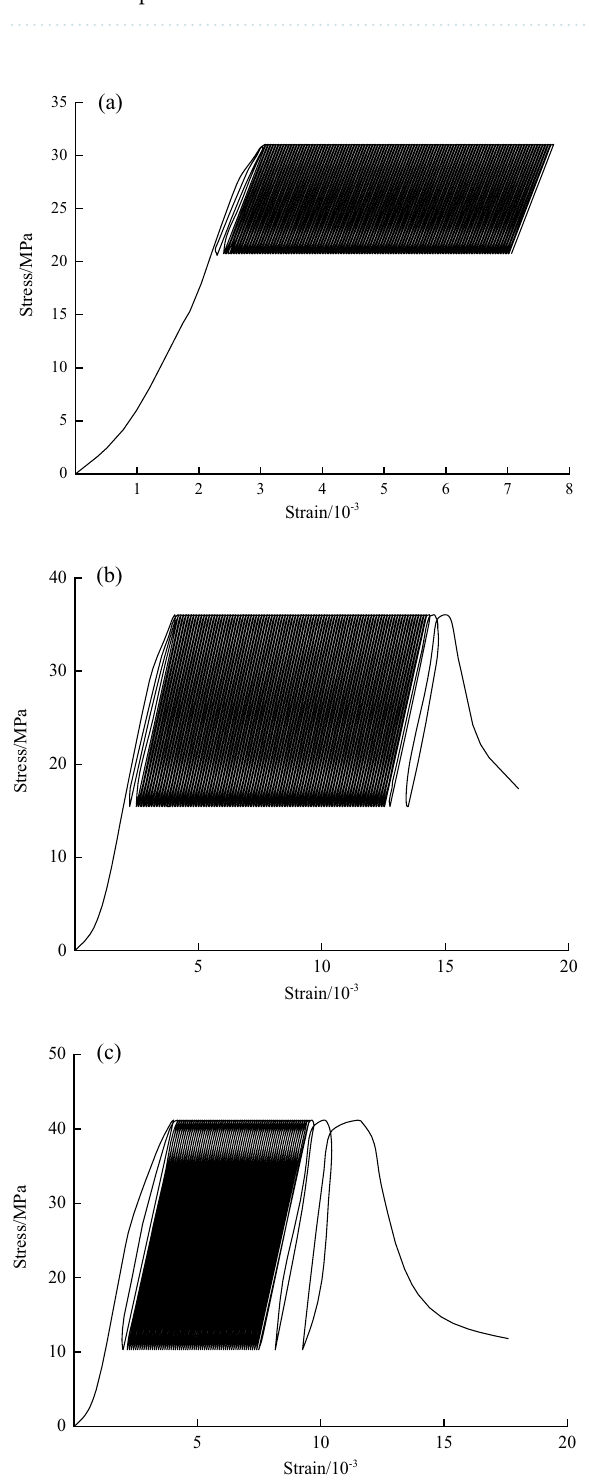
Figure 7. Cyclic loading stress ‒ strain curves at different stress amplitudes: ( a ) �σ = 5 MPa , ( b ) �σ = 11 MPa , ( c ) �σ = 15 MPa